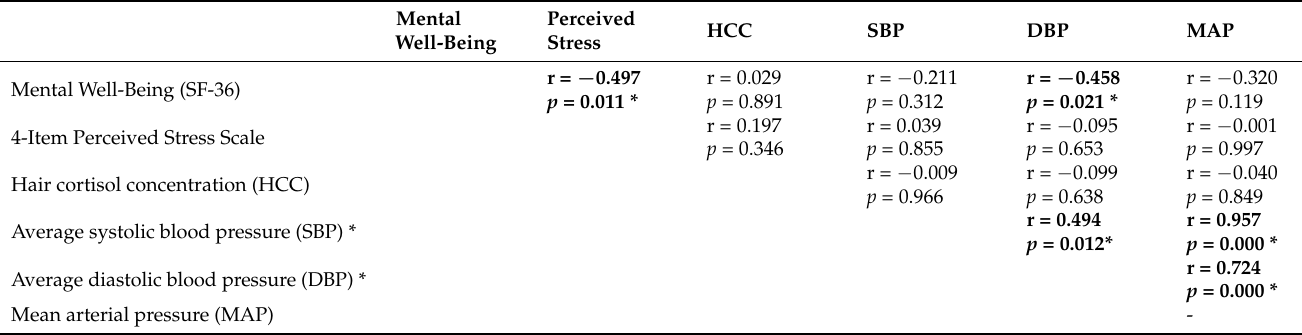
Table 2. Pearson’s correlations for the variables in analysis ( N = 25).